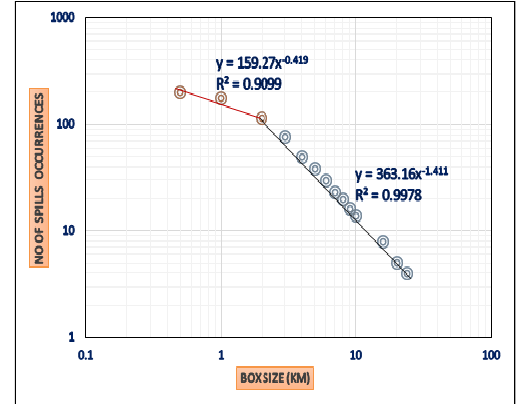
Figure 7. Box count dimension of general oil spills